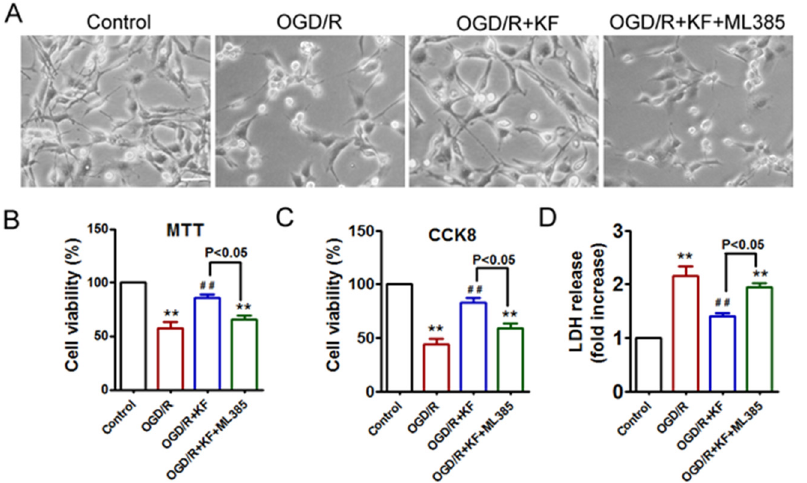
Figure 6. Effects of kaempferol on cell viability and cell death in OGD/R-treated neurons. Neurons were treated as indicated in (Figure 1A). ( A ) Phase contrast imaging of live neurons. Scale bar, 50 µm. ( B – D ) Cell viability and cell death were measured by MTT assay ( B ), CCK-8 ( C ), and LDH ( D ), respectively. Three independent experiments were performed with similar results. ** p < 0.01 versus control; ## p < 0.01 versus OGD/R.